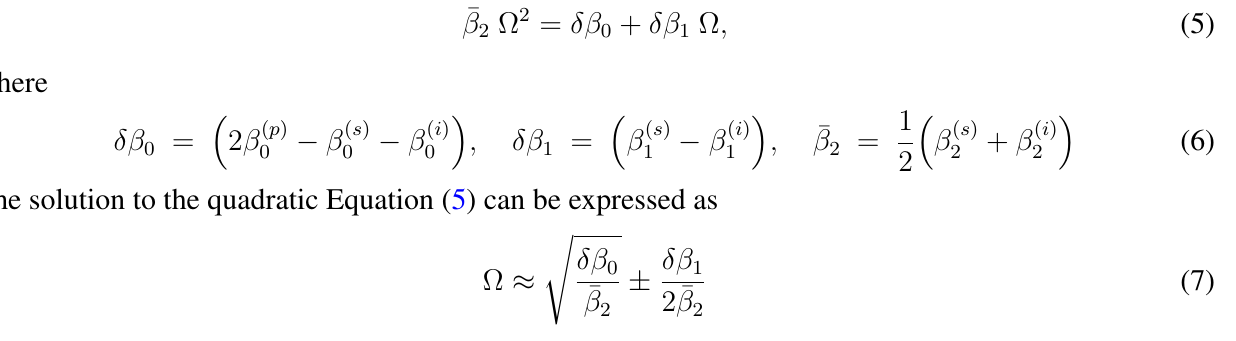
Idler, pump, and signal interact via the degenerate FWM mechanism inside an optical fiber. ( a ) In scenario (a) , the input source and its frequency-doubled daughter constitute the pump-signal ( ω source and its frequency-doubled daughter constitute the the idler-signal ( ω ω = 2 ω ; and ( c ) scenario (c) with idler-pump ( ω i s so it is